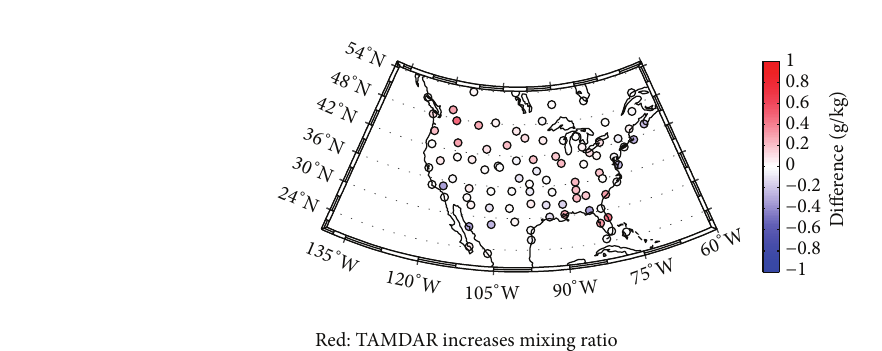
Figure 7: The same as Figure 5 except for relative humidity (%).